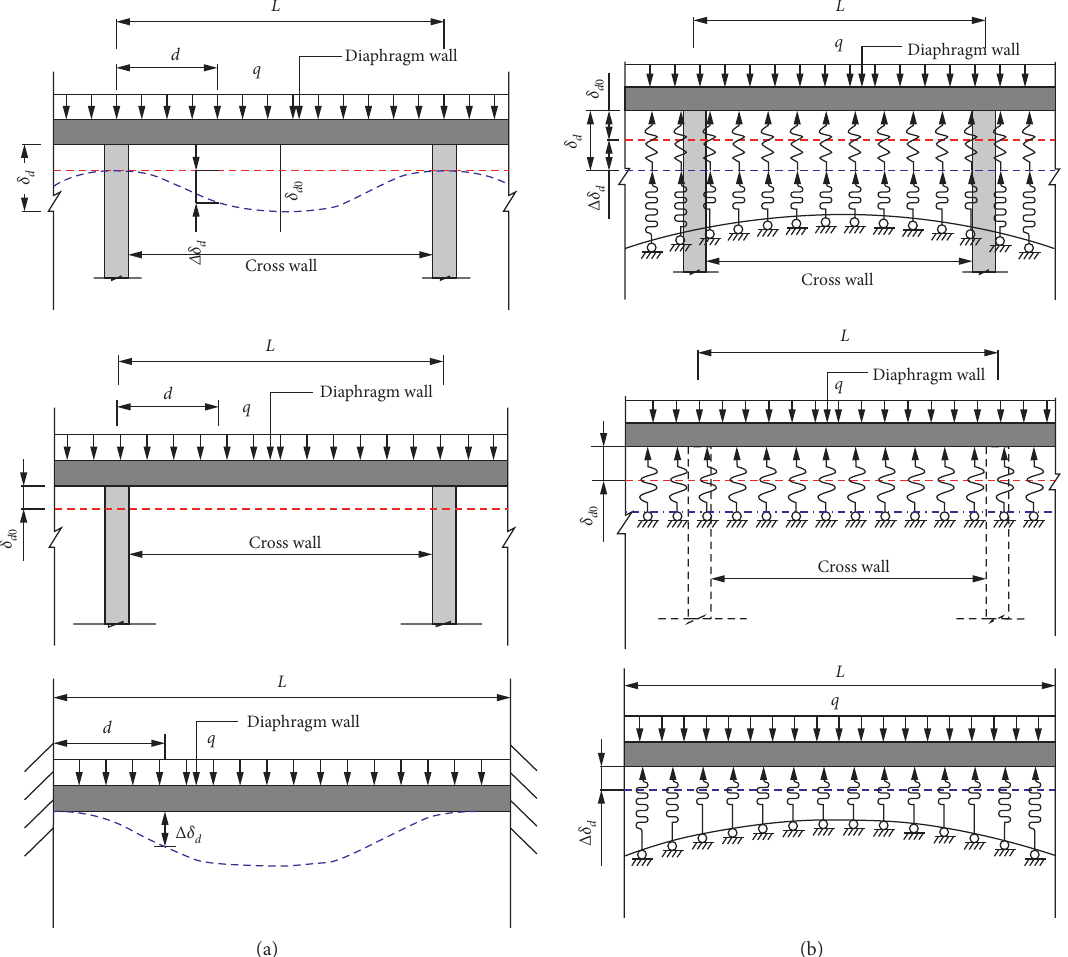
Figure 4: Derivation of the MEFB method. (a) Deformation mechanism and equivalent stiffness of the diaphragm-cross wall system. (b) Deformation mechanism and equivalent stiffness of the simply supported beam. (c) Deformation mechanism and equivalent stiffness of a fixed beam.